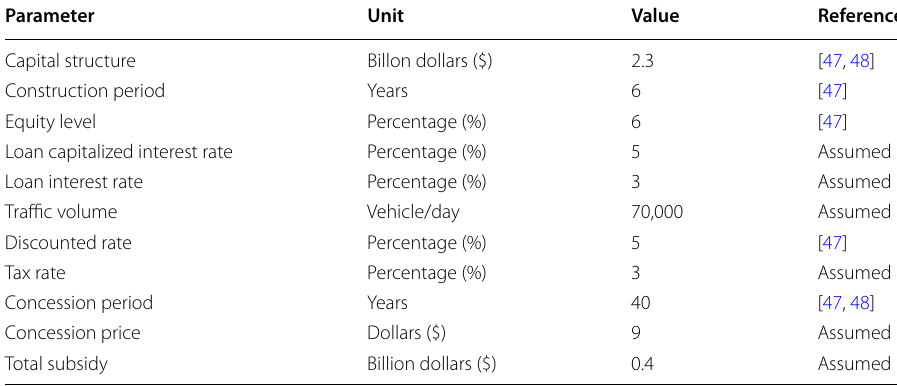
Table 3 Model parameters for the I-4 Ultimate